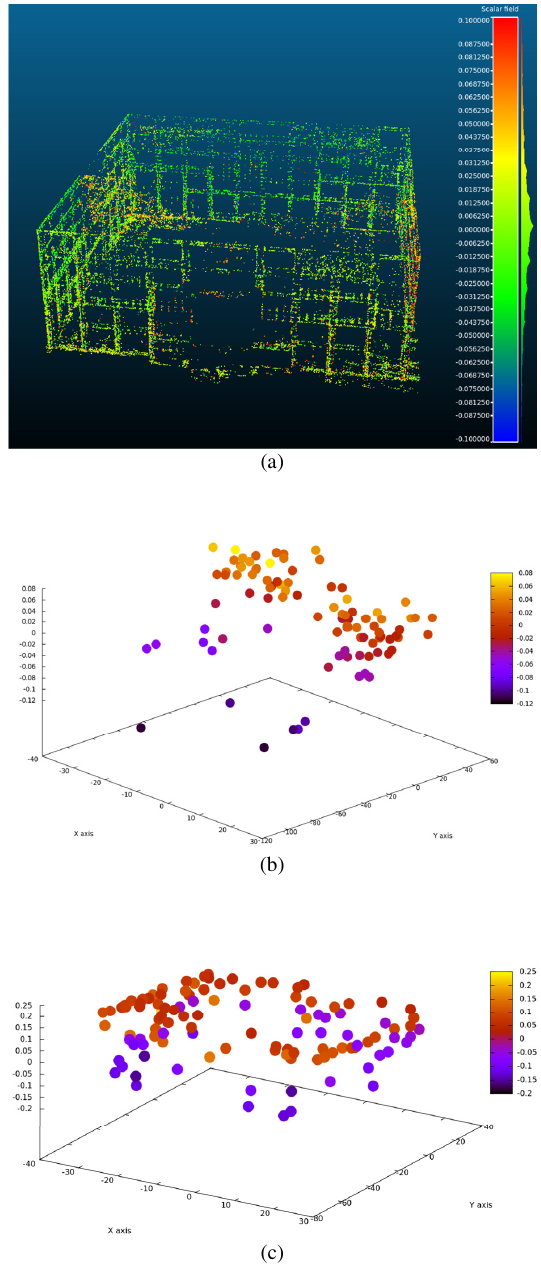
Figure 12. Evaluation of tie point quality: (a) signed orthogonal distance per each tie point, (b) signed mean vertical distance per reference plane, (c) signed mean horizontal distance per reference plane. The horizontal offset, (Fig. 12c) indicates that in the front left area the shifts are largest (up to 20cm, orange dots), while in the other parts of the object they are quite small, max. 8cm (violet